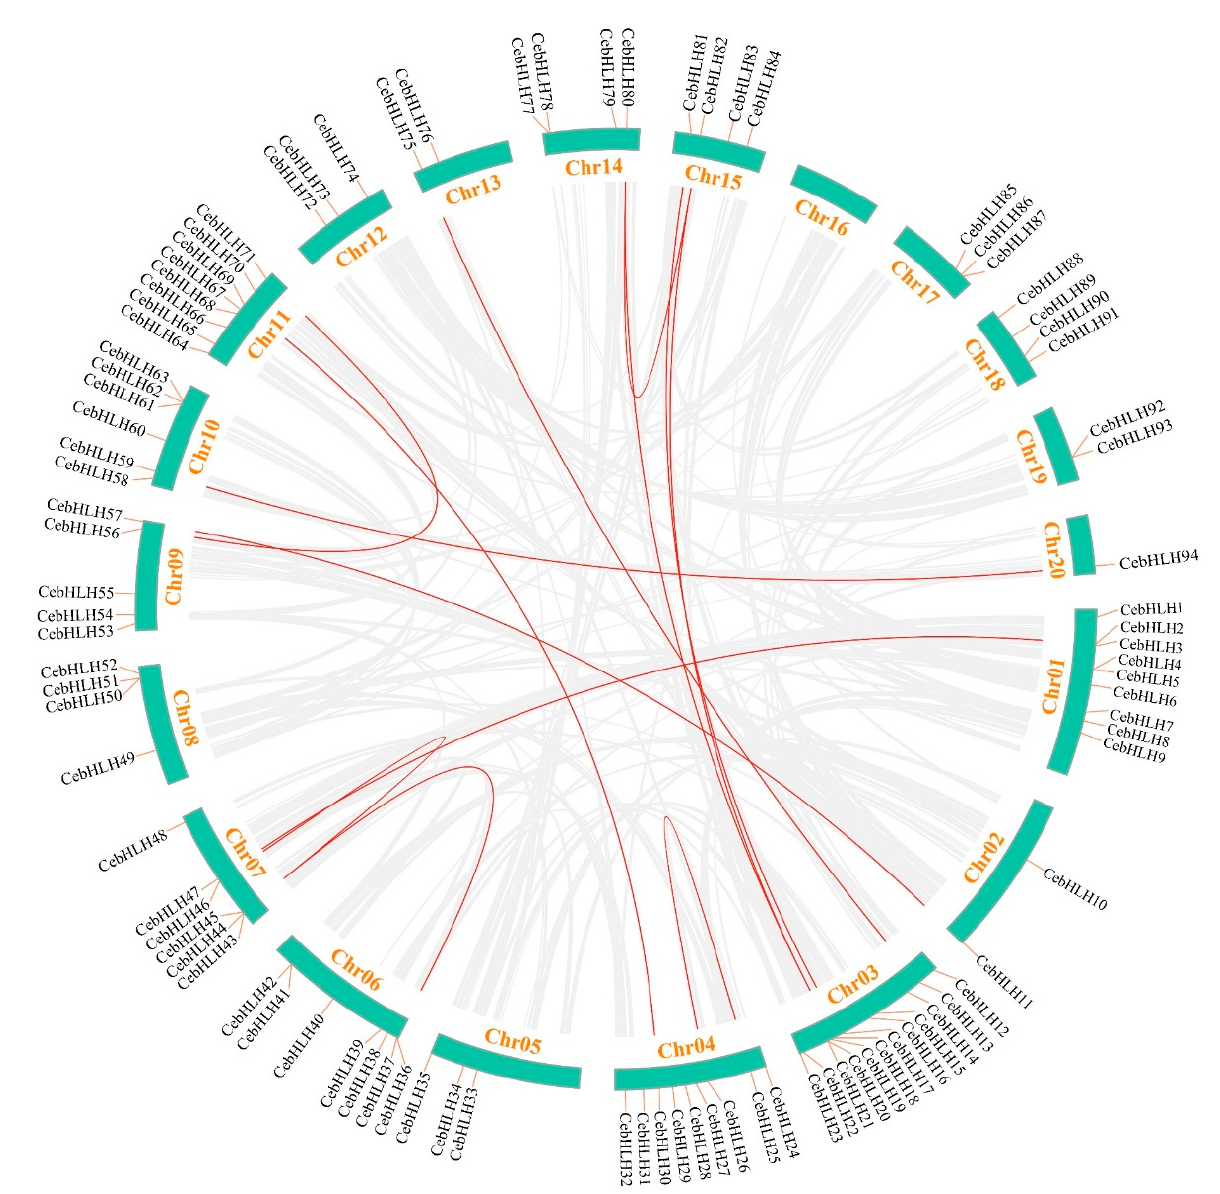
Figure 6. Collinearity analysis of CebHLHs . The duplicated gene pairs in the genome were linked by red lines.